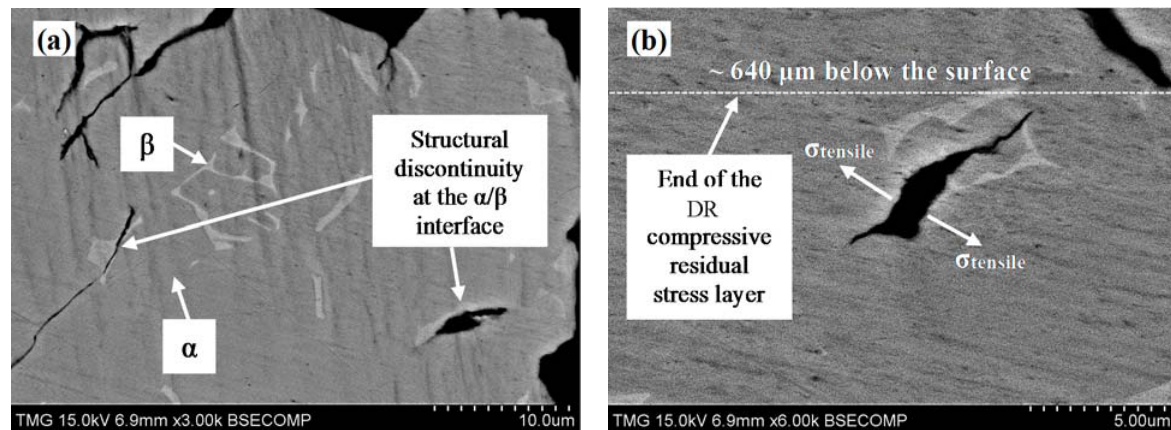
Figure 17. Initiation and propagation of the sub-surface micro-cracks due to the effect of